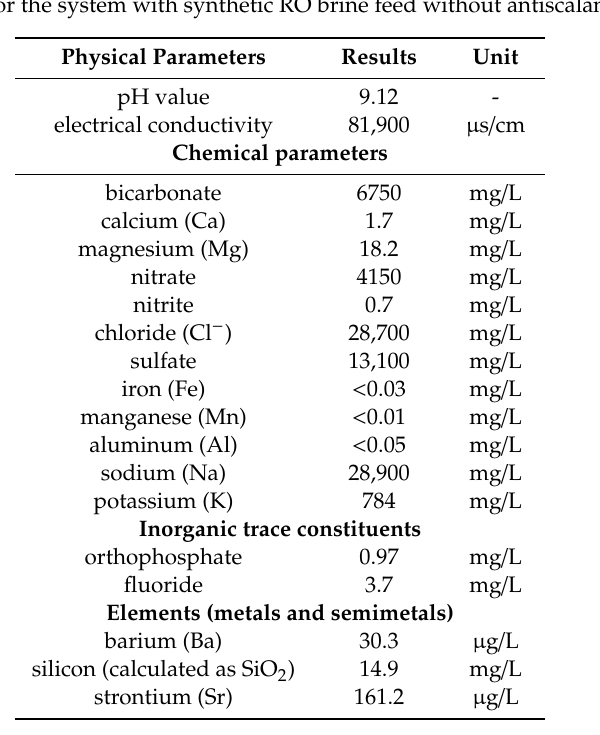
Figure 3. Permeate flux and permeate electrical conductivity as functions of time for the synthetic feed system without antiscalant. The permeate flux decreased, which indicates fouling, but permeate electrical conductivity remained at low levels, which indicates the absence of wetting. Feed temperature, permeate temperature, and gauge pressure were kept constant at 75 ◦ C, 21 ◦ C, and − 30 mbar during the experiments, respectively. Table 3. Chemical analysis of the retentate (liquid solution and not including in-situ crystals) obtained after the experiment for the system with synthetic RO brine feed without